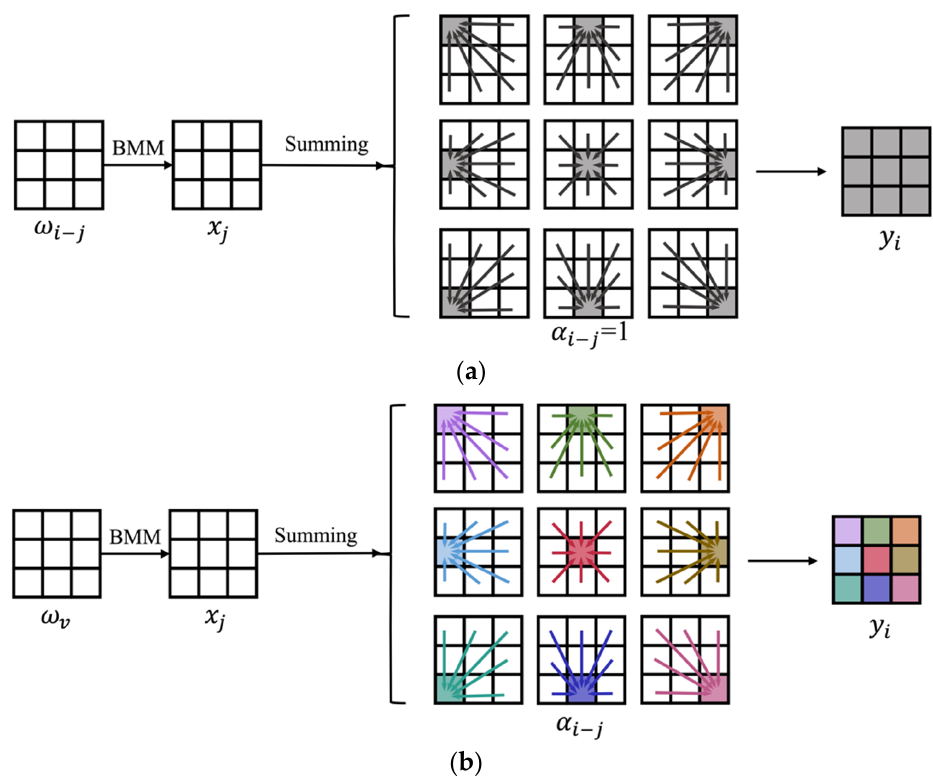
Figure 6. Illustration of the convolution and self-attention calculation. ( a ) The convolution calculation, ( b ) the self-attention calculation.